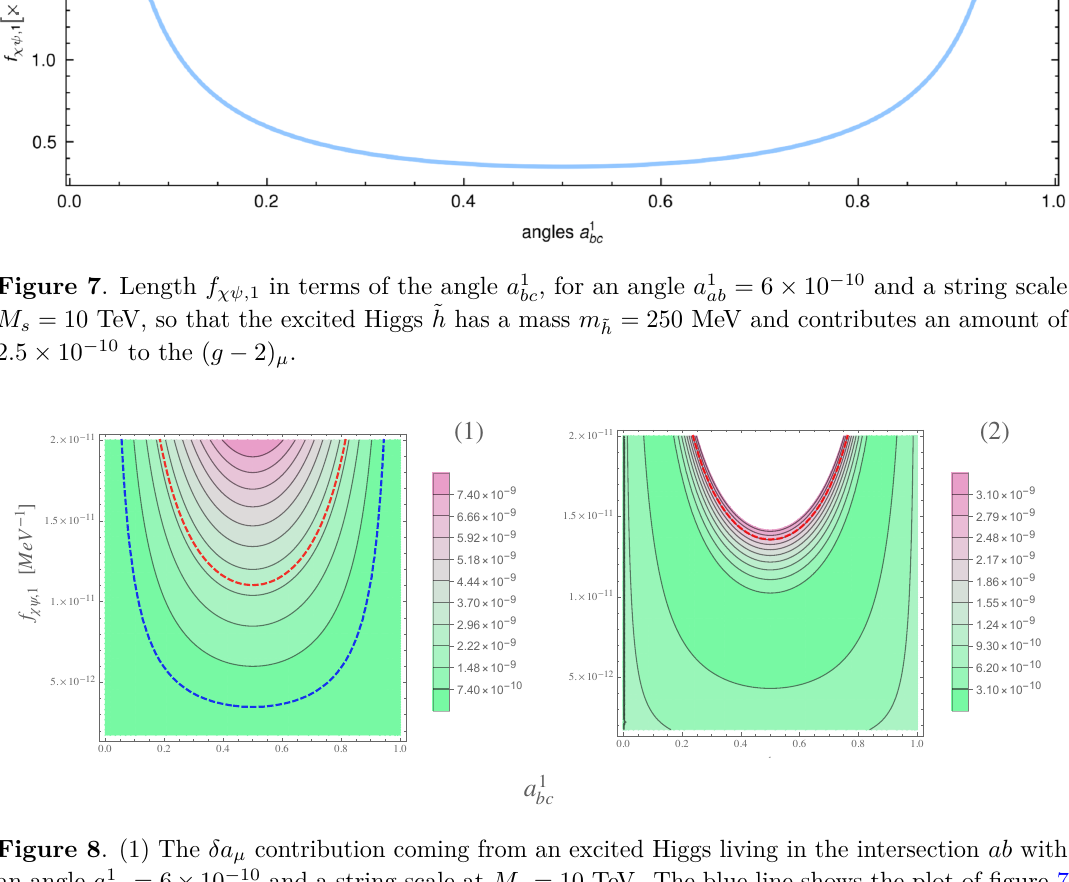
Figure 8 . (1) The δa µ contribution coming from an excited Higgs living in the intersection ab with an angle a 1 = 6 10 − 10 and a string scale at M s = 10 TeV . The blue line shows the plot of figure 7 ab × embedded in this result, and the red line the full discrepancy (1.6). (2) The contribution to the δa µ coming from the double excited Higgs, living in the same intersection ab . Again the red line shows the full discrepancy